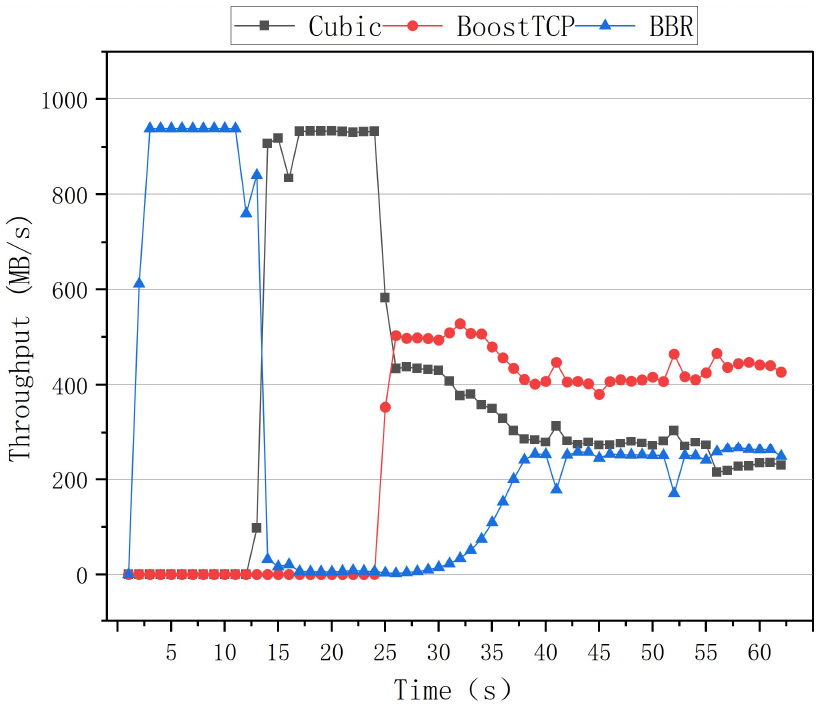
Figure 14. The preemptive test curves of the three congestion control algorithms at a network delay of zero and a packet loss rate of zero.